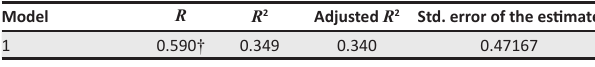
TABLE 5: Model summary table for the multiple regression